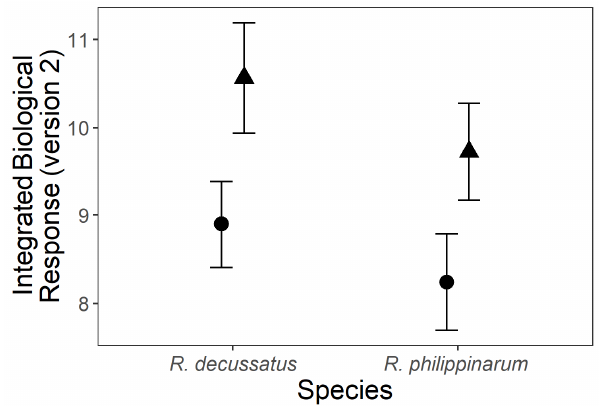
redistribution ( f-SPI L mean ), ( c ) median mixed depth of luminophores’ redistribution ( f-SPI L median ), and ( d ) maximum mixed